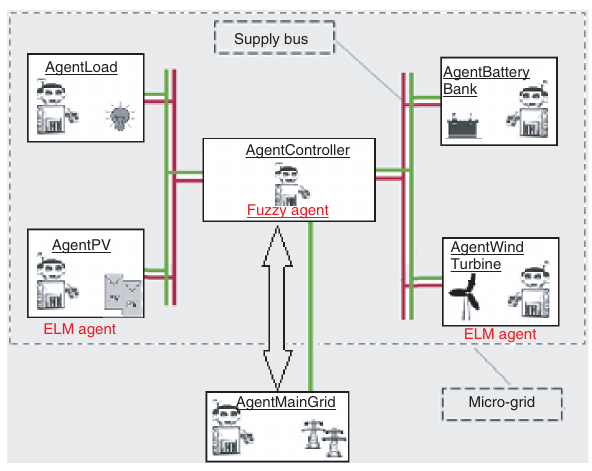
Figure 5: MAS Architecture of the Adopted MG.